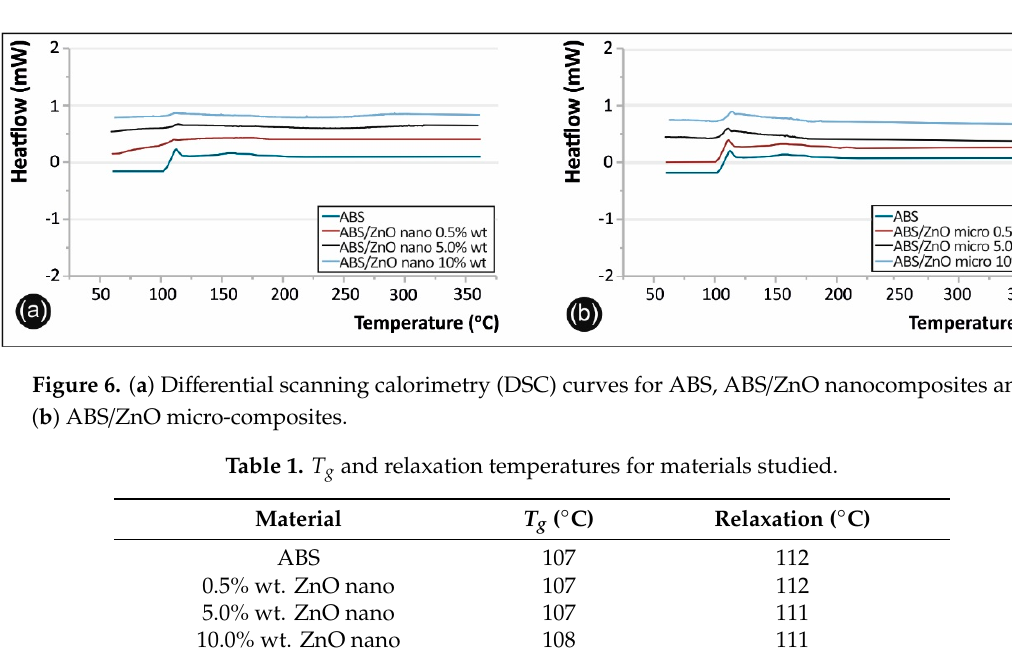
Figure 5. Thermogravimetric analysis (TGA) mass loss versus temperature curve for the ABS Terluran Hi-10 experimentally determined in this work and ABS polymer matrix manufacturer properties (courtesy of Ineos Styrolousion, material datasheet).